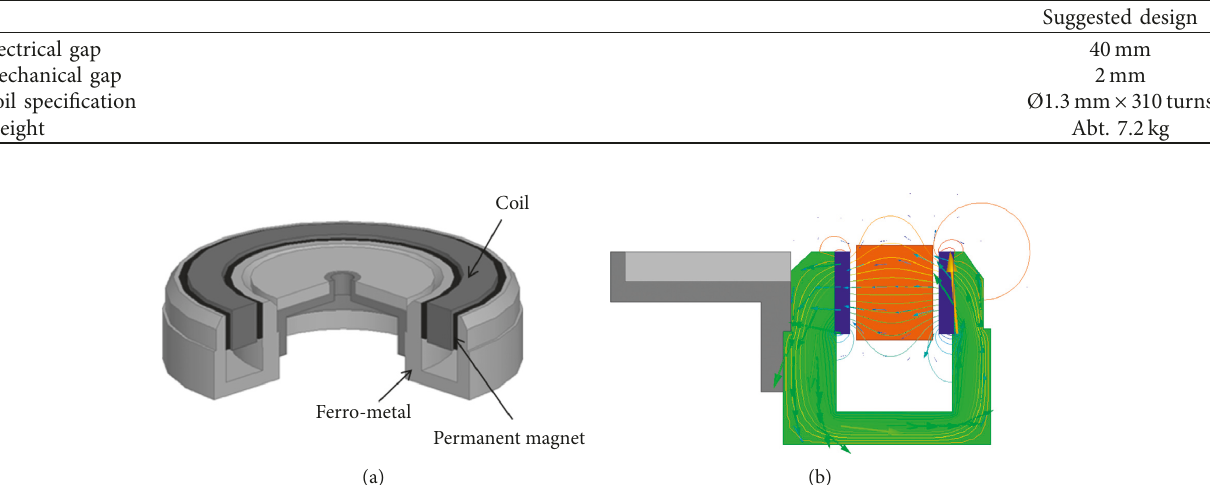
Table 6: Design specification for suggested electromagnetic actuator.